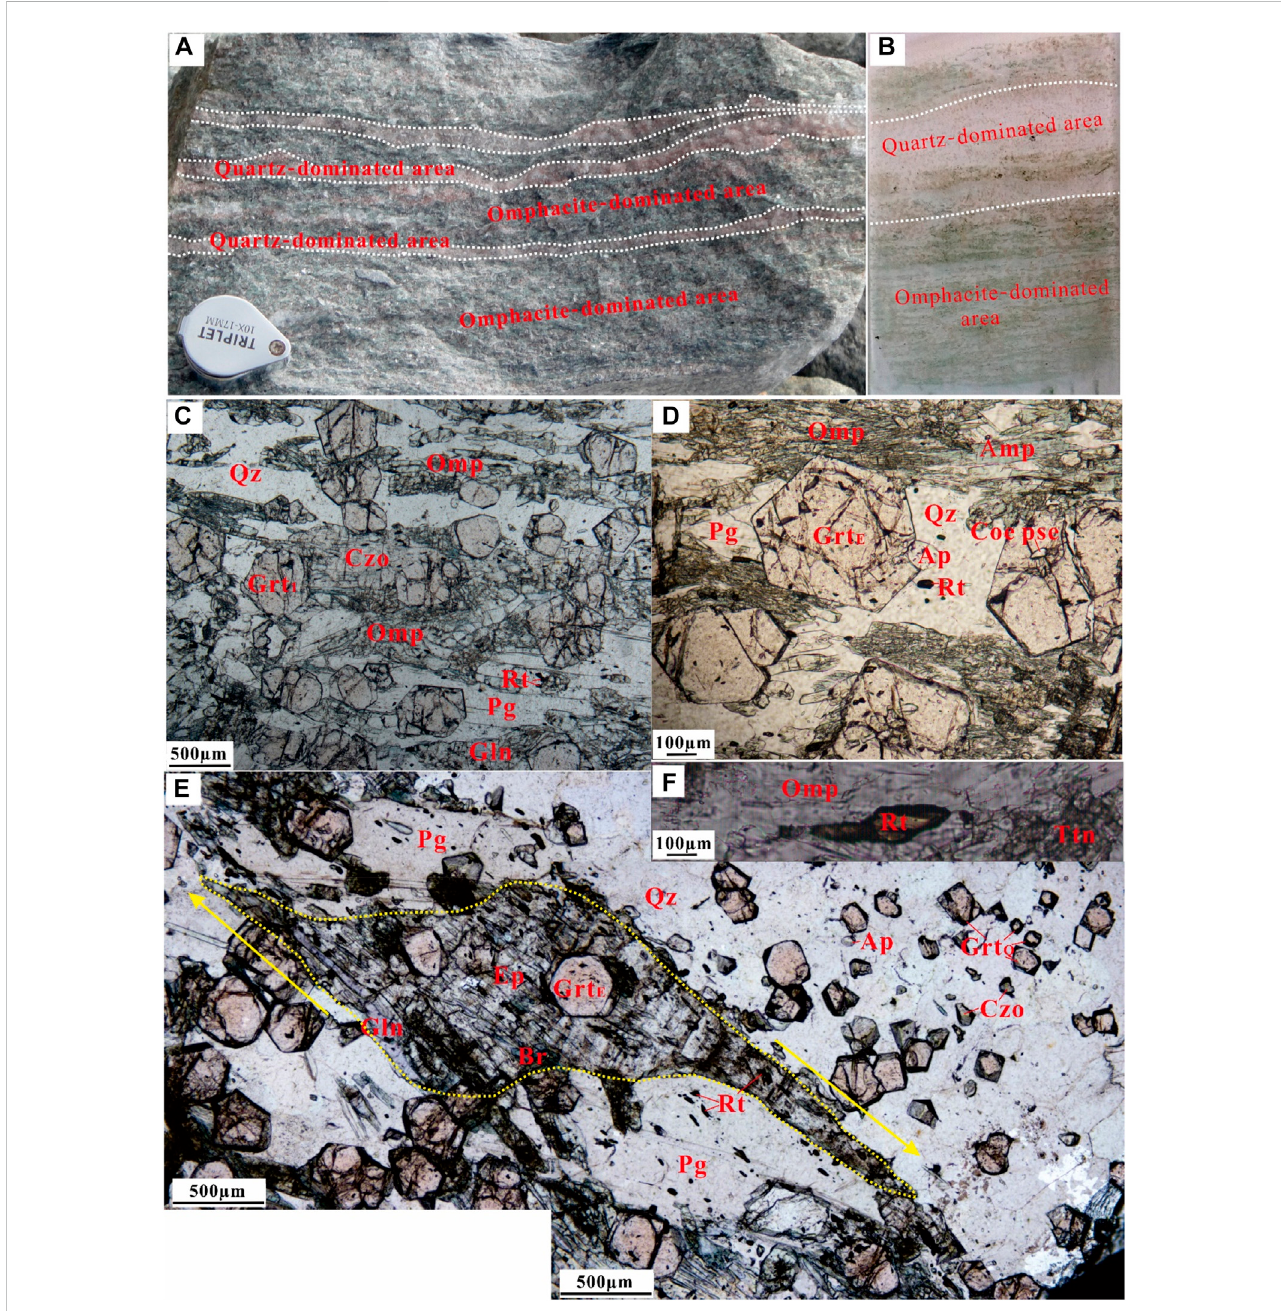
Features and deformation of the eclogite-facies felsic schist sample HB121-2. The hand specimen (A) and thin section (B) show the strong deformation and obvious segregation into omphacite- and quartz-dominated areas. Photomicrographs (C – F) of the eclogite-facies felsic schist. (C – D) Eclogite- dominated area consists mainly of garnet, omphacite, quartz, paragonite, epidote, glaucophane, barroisite, and accessory rutile, apatite, and zircon. (E) Garnets are big in the omphacite-dominated area (Grt E ), but relatively small in the quartz-dominated area (Grt Q ). Clinozoisite porphyroclasts show σ shapes. (F) Rutile in the eclogite-dominated area is strongly oriented and